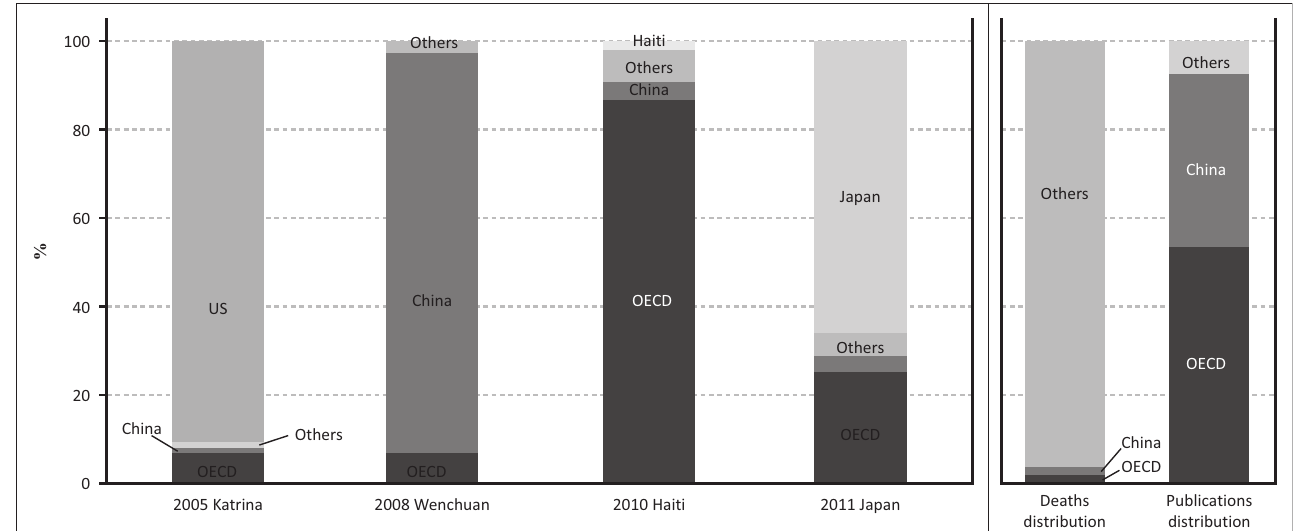
FIGURE 2: Right-hand side: Geographic distribution of deaths and publications (based on affiliation of lead author) for the 15 most deadly disasters between 2005 and 2014; left-hand side: Geographic distribution of publications (based on affiliation of lead author) for the four disasters which have stirred the greatest interest between 2005 and